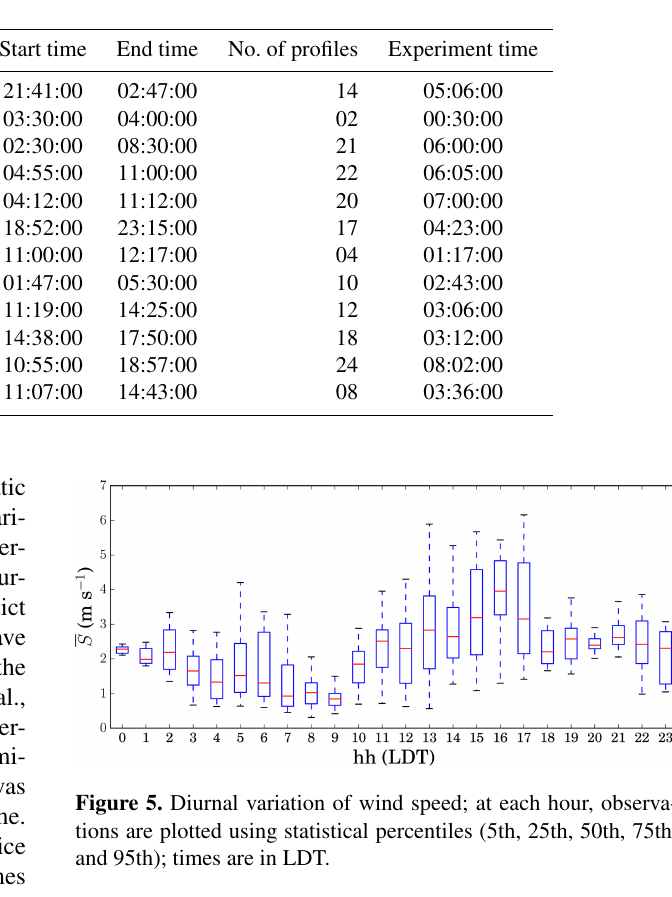
Table 1. TAB launch details; times are in Local Daylight Time (LDT).